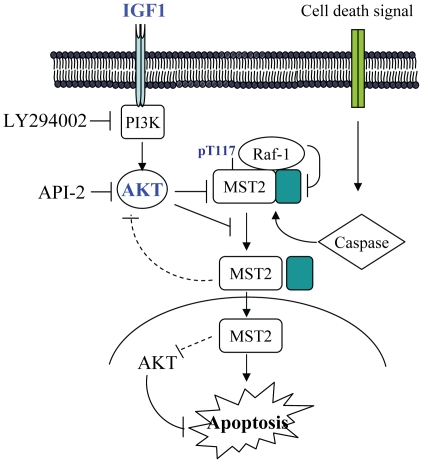
A diagram represents the regulation of MST2 by IGF1/Akt signal.Under stress conditions, MST2 is activated through caspase-3 cleavage and autophosphorylation-Thr180. The activated/cleaved MST2 translocates to the nucleus and promotes apoptosis. IGF1/Akt inhibits these processes through phosphorylation of MST2-T117.